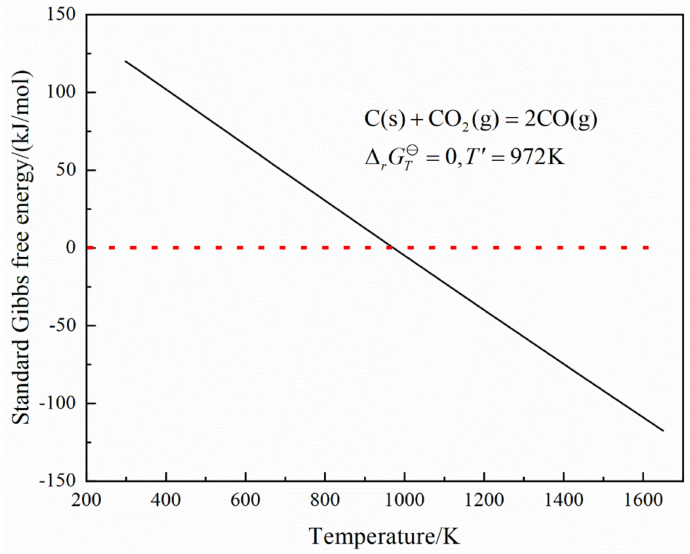
Figure 6. The standard Gibbs free energy of gasification reaction between carbon and CO 2 .